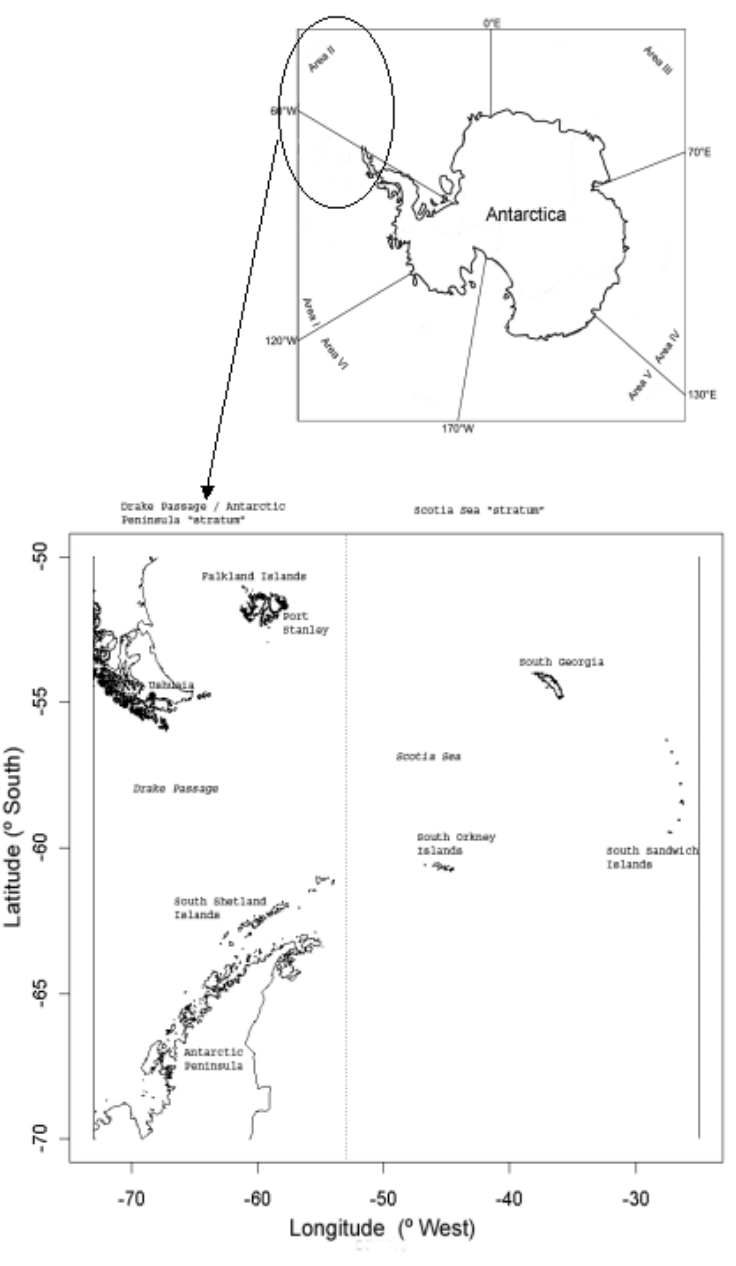
Fig. 1. Study area in the context of International Whaling Commission (IWC) Antarctic baleen whale areas. Most trips left from Ushuaia, Argentina or Port Stanley, Falkland Islands [Islas Malvinas]. Trips to the Antarctic Peninsula were more common than those to South Georgia, necessitating a post hoc designation of an Antarctic Peninsula–Drake Passage stratum (left of the dotted line) and a Scotia Sea (right of the dotted line)